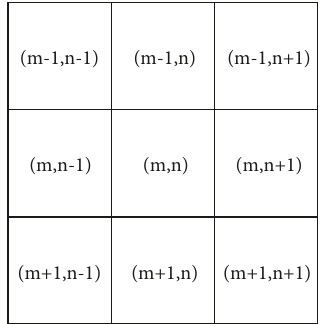
Figure 4: An ant’s current position with 8 possibly positions for